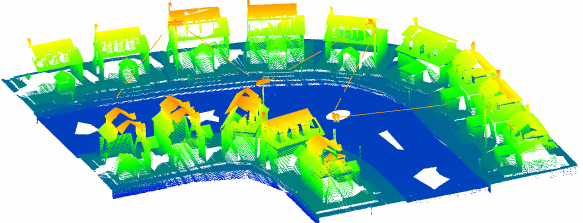
Figure 1. Example of a point cloud generated from a simulated model containing more than two million